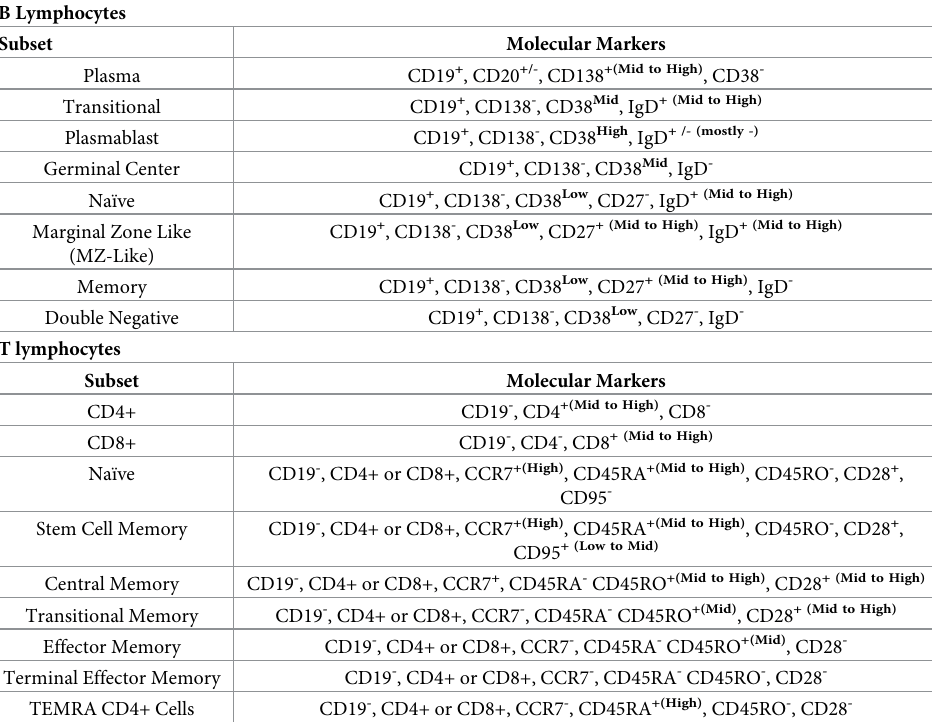
Table 2. Lineage definitions for lymphocyte subsets used in the